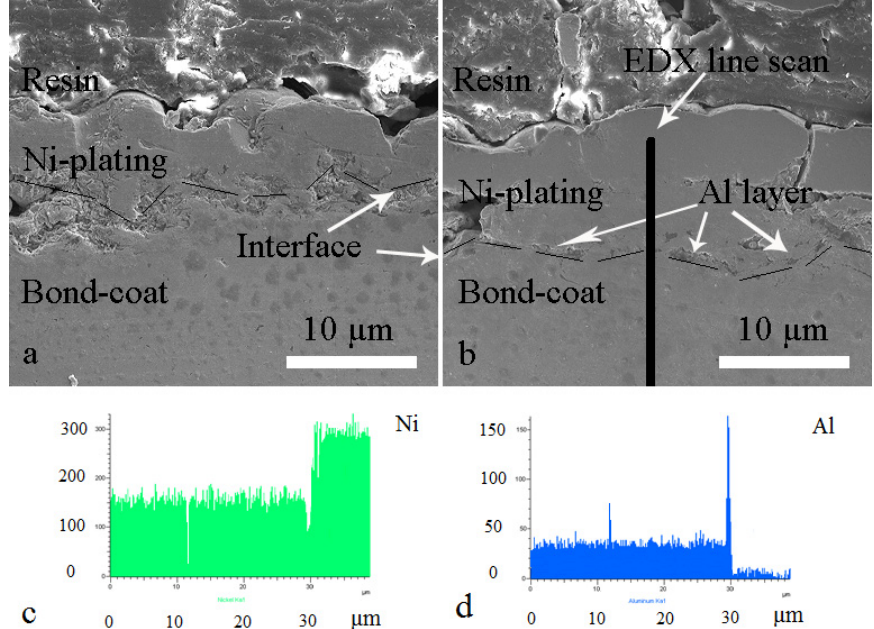
Figure 2. Cross-sectional view of SEM micrographs of NiCrAlY bondcoat ( a ) as-sprayed sample, ( b ) Al coated sample. EDX line scan profile of ( c ) Ni and ( d ) Al, showing the Al layer.